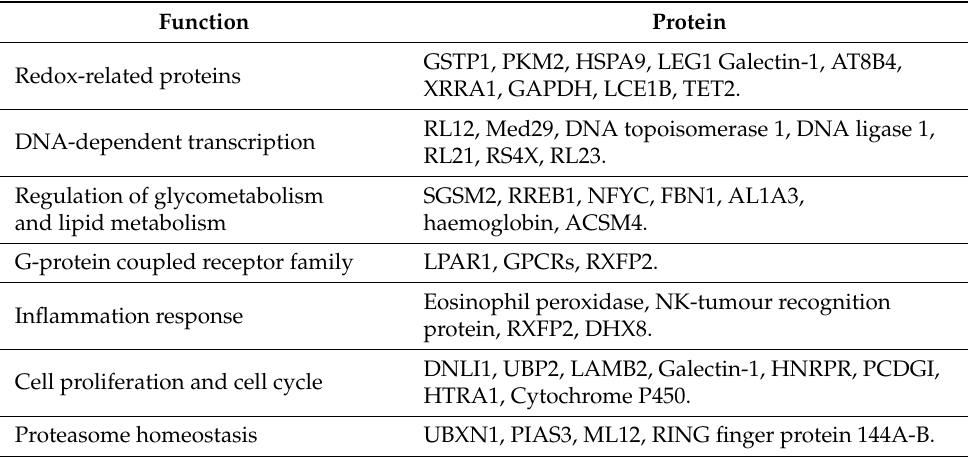
Table 1. Arsenic-binding proteins identified by